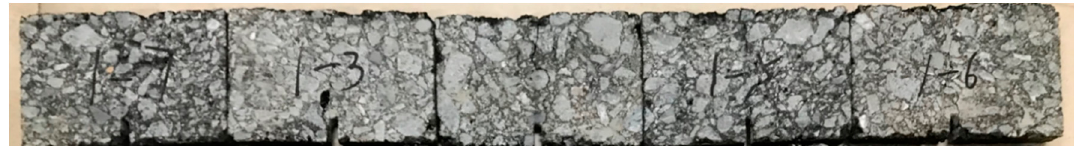
Figure 3. Grading curve of AC-13 steel wool fibers modified basalt asphalt mixture.